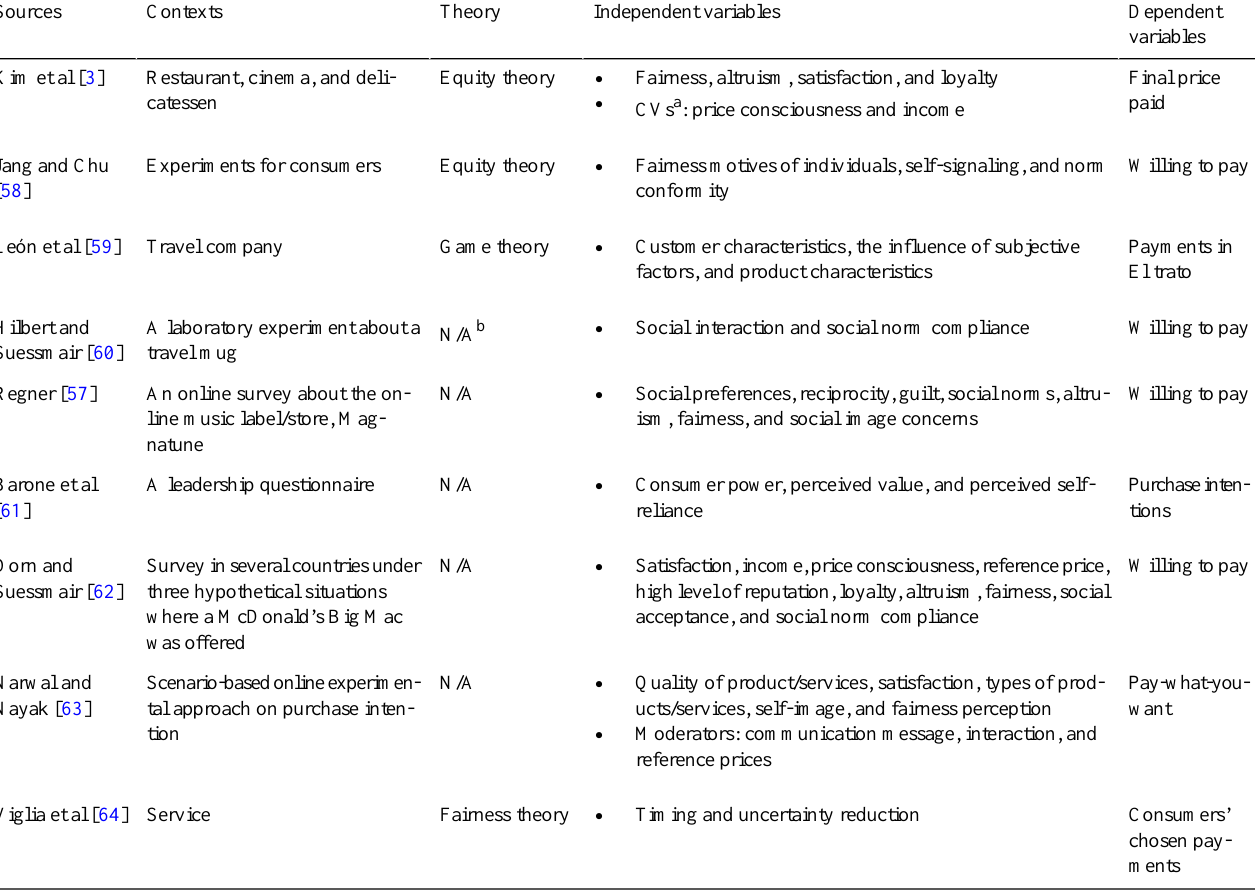
Table 1. Key constructs related to the pay-what-you-want behaviors in prior